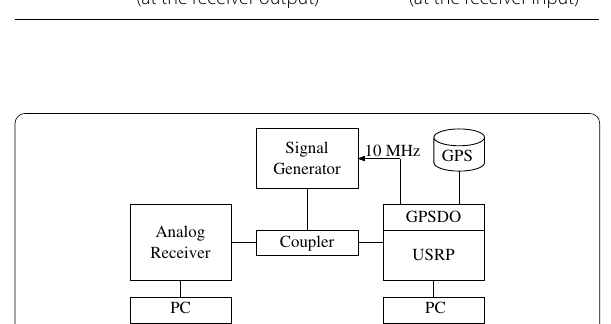
Fig. 5 Schematic of the evaluation system of the new digital receiver (USRP). In this system, the 10-MHz reference signal output from the GPS-Disciplined oscillator (GPSDO) was supplied to the signal generator. Using a coupler, the signal from the signal generator was supplied to both analog and digital receivers simultaneously. The outputs from both receivers were processed by separate PCs